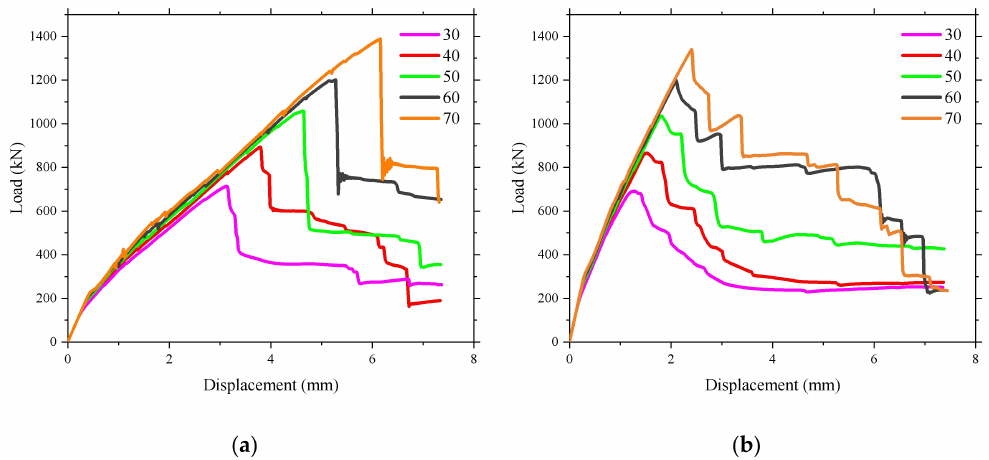
Figure 26. Influence of concrete compressive strength on the ultimate bearing capacity. ( a ) Loading between the W-beams; ( b ) Loading between W-beams and W-beams.